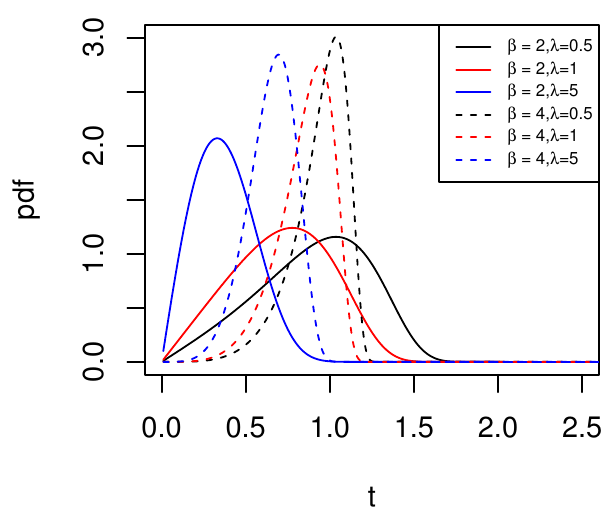
Figure 4. pdf of Chen ( t ; β , λ ) , β >